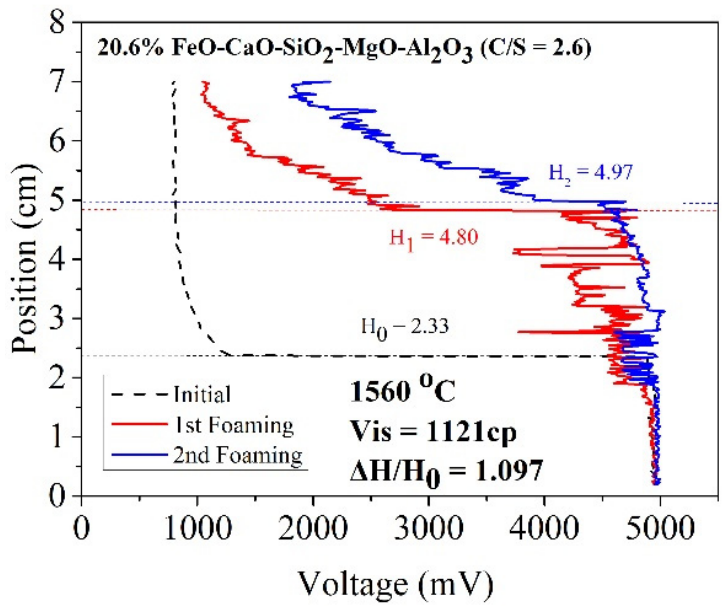
Figure 9. Foaming height of sample B1.